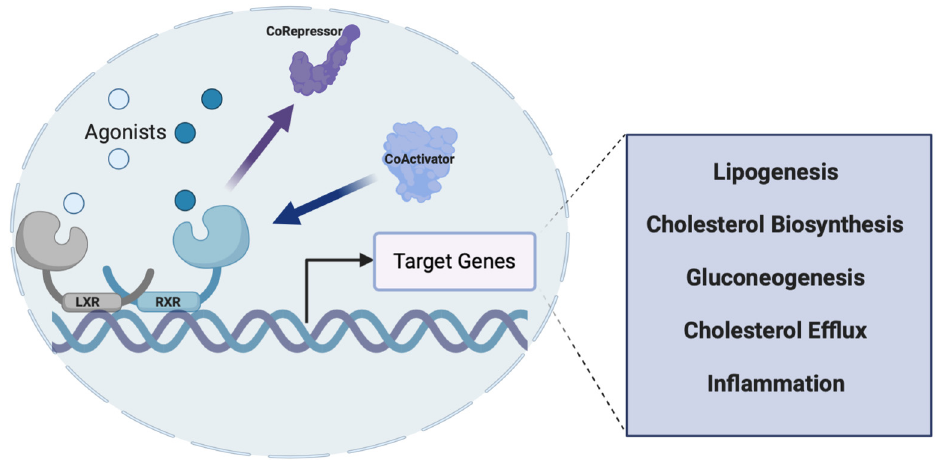
Figure 7. Mechanism of action of the LXR receptors. LXR heterodimerizes with RXR and recognizes specific DNA sequences (LXRE) within the promoter of its target genes. While there is some basal level of activity, upon agonist binding (natural or synthetic), a conformational change occurs that causes the recruitment of co-activators and allows for transcription of the target gene to occur. Genes involved in lipogenesis, cholesterol biosynthesis, gluconeogenesis, and inflammation are all regulated by LXRs, making this nuclear receptor a potential therapeutic target for NAFLD. Figure created with BioRender.